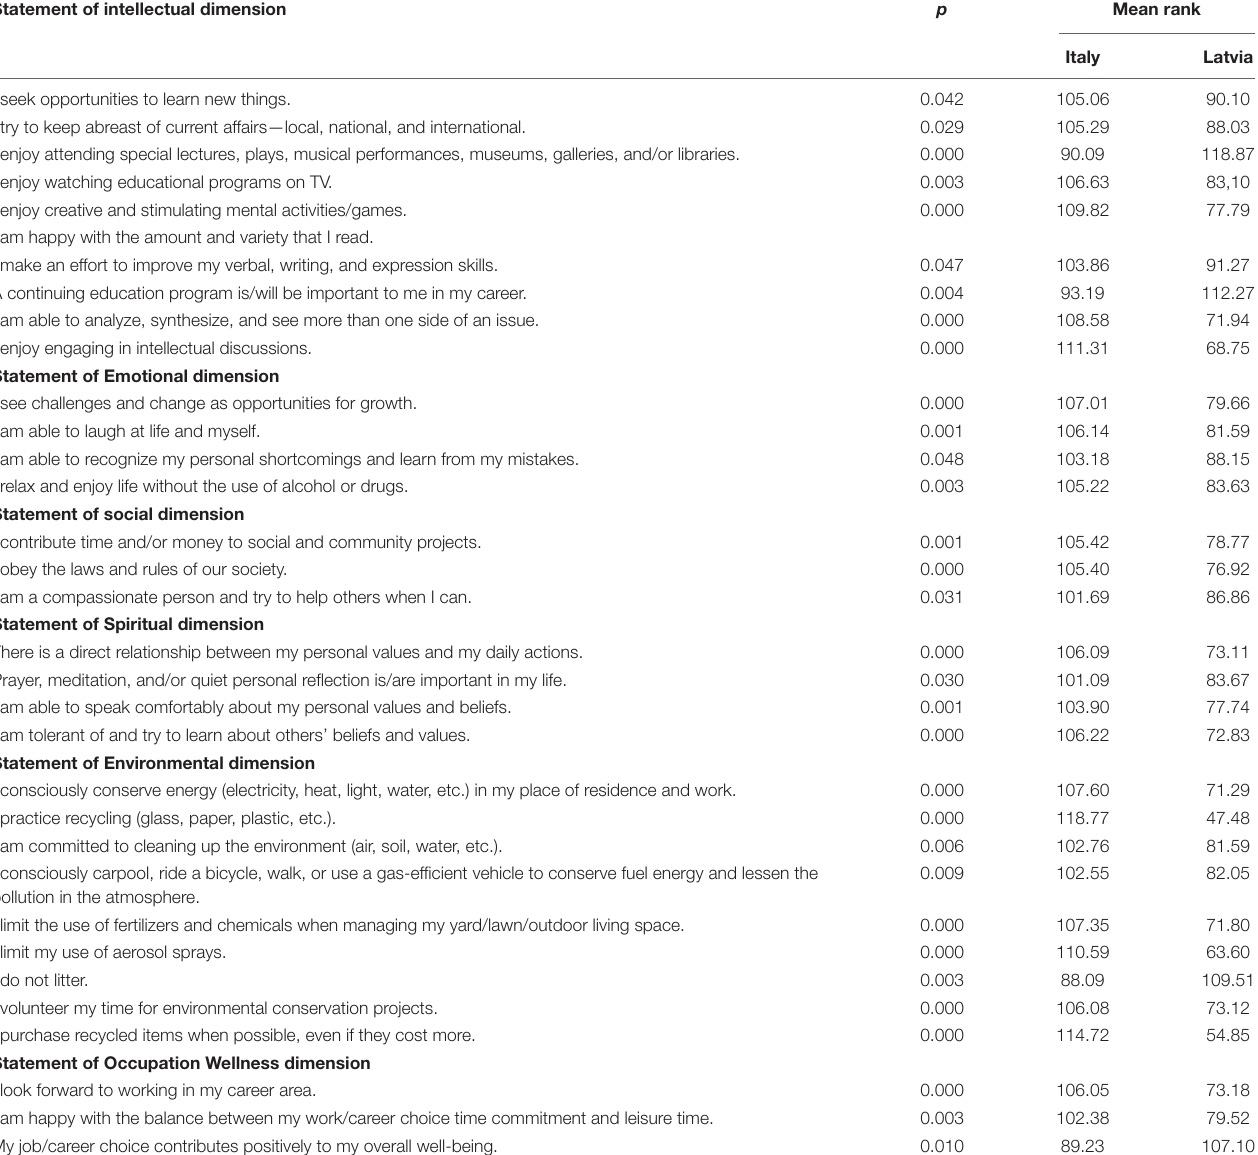
TABLE 7 | Differences between indicators of wellness dimensions for Latvian and Italian sport